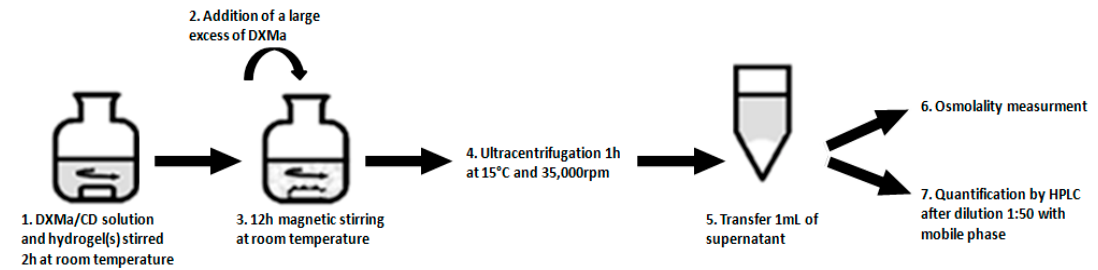
Figure 2. Steps implemented for the experimental design with 29 experiments.